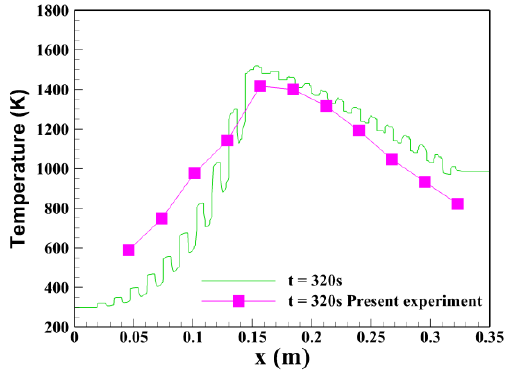
Figure 6. Comparison of temperature profiles by numerical prediction and experimental result.